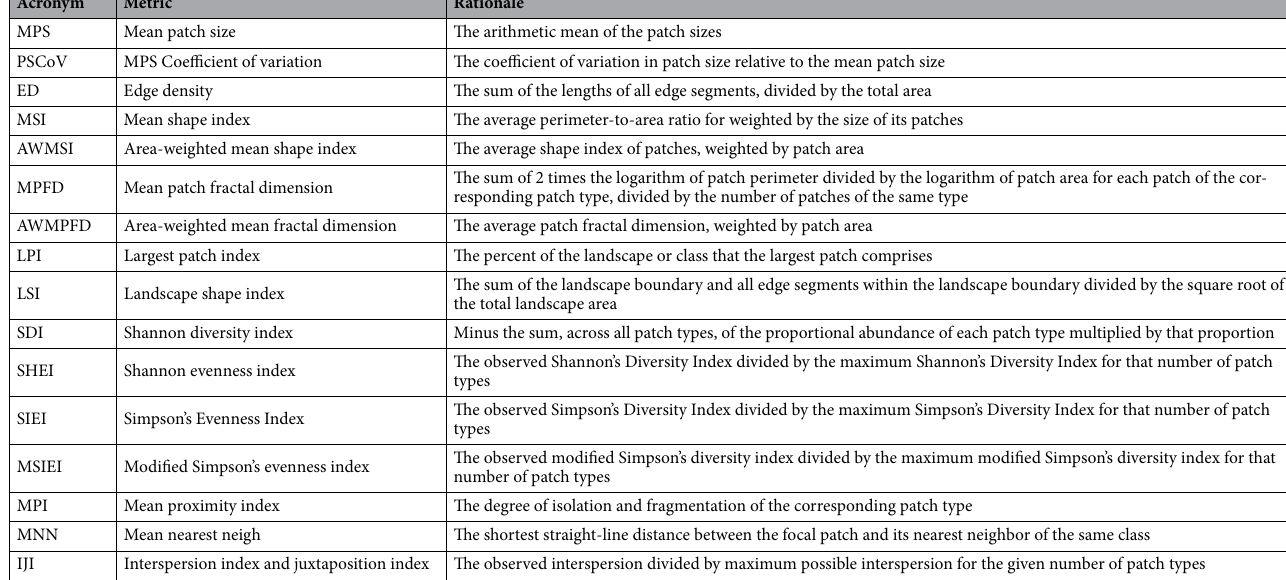
Table 1. List of landscape metrics assessing the spatial distribution of land vulnerability to degradation in